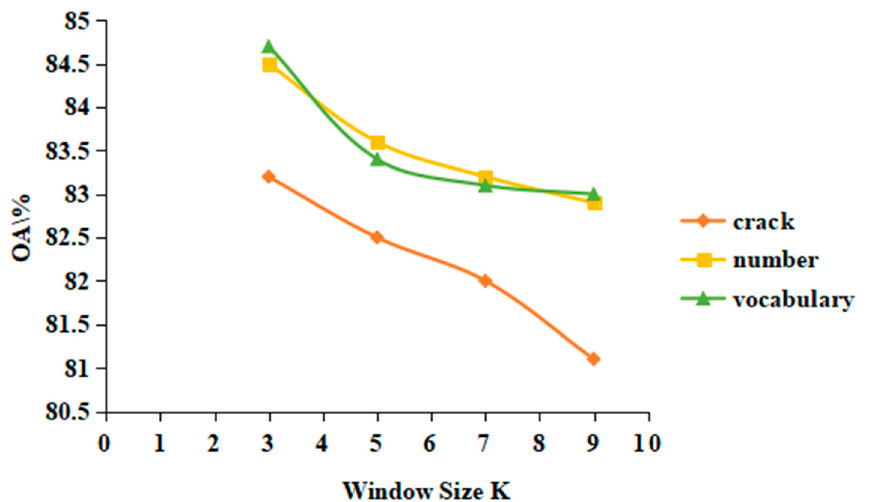
Figure 6. Detection accuracy comparison of different window size for GLGM.